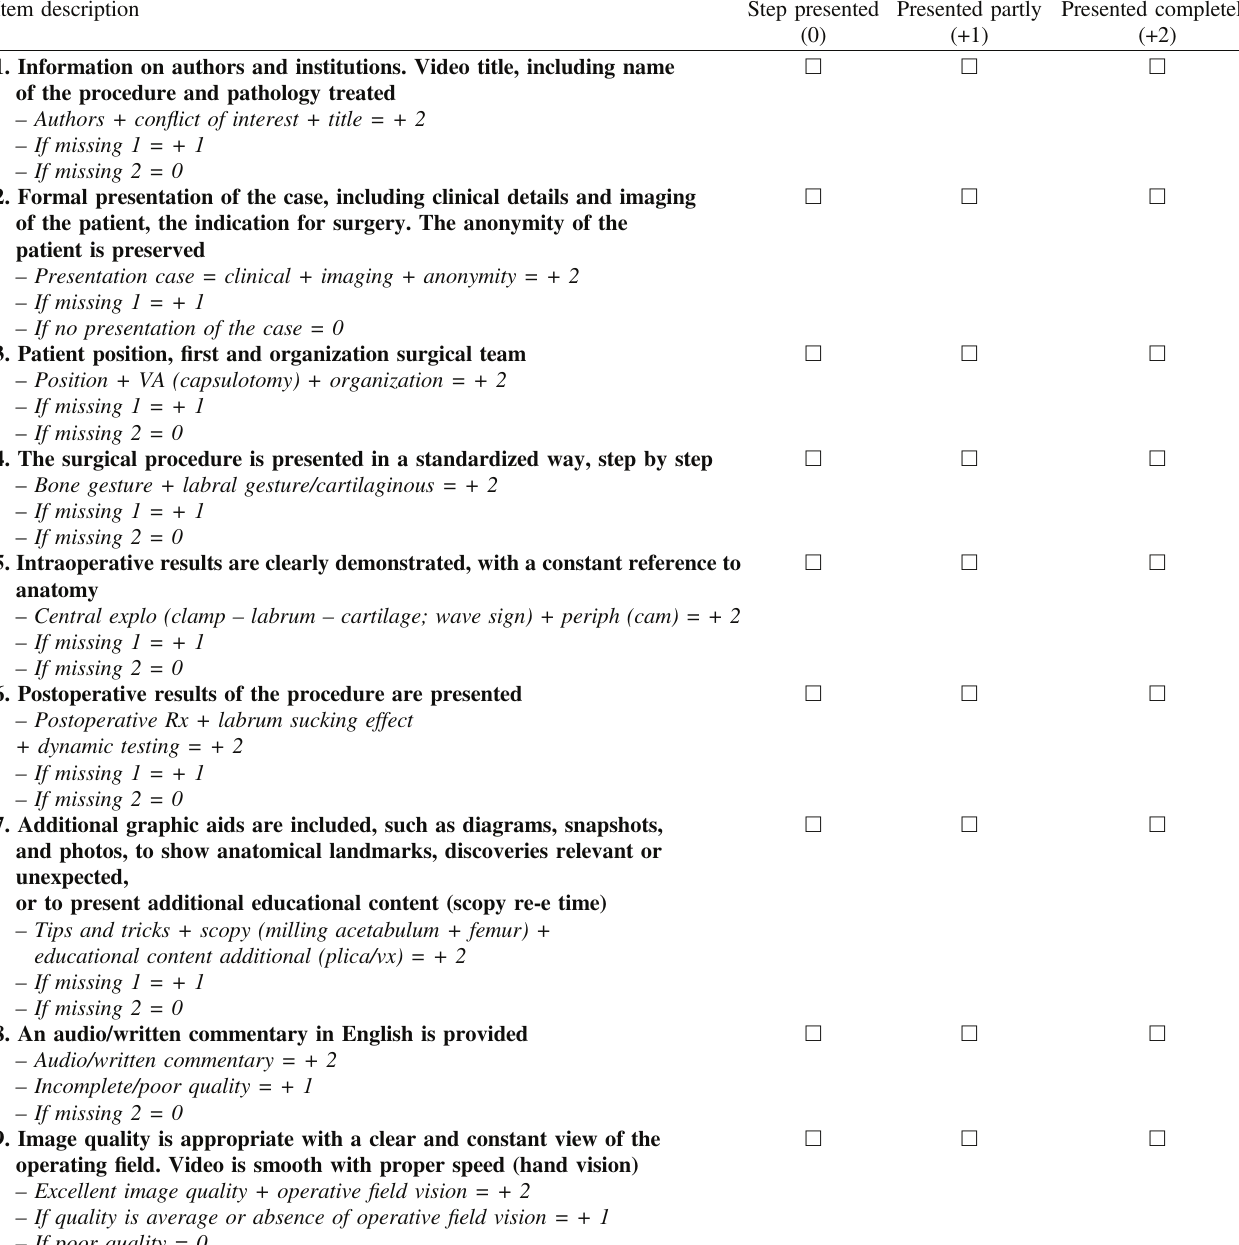
Table 1. LAP-VEGaS Video Assessment Tool (original in bold)/LAP-VEGaS-FAI (modi fi ed in